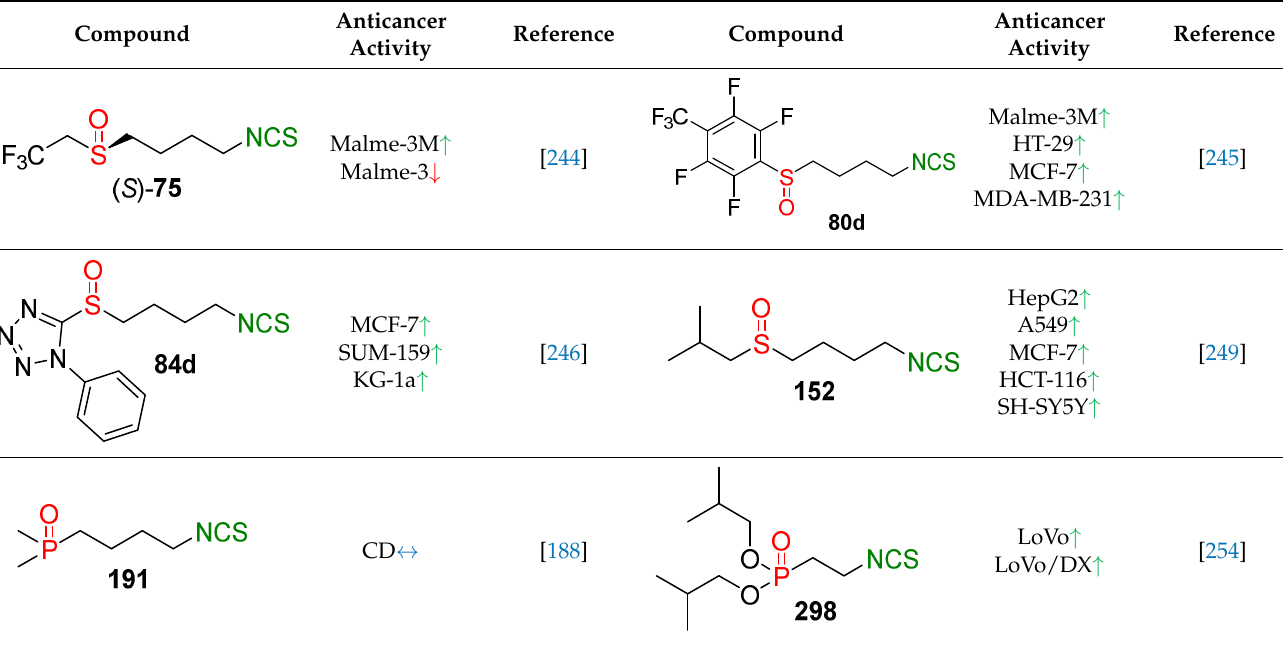
Table 13. Summary of the relationship between the biological activities of the analogs of SFN and various functional groups.